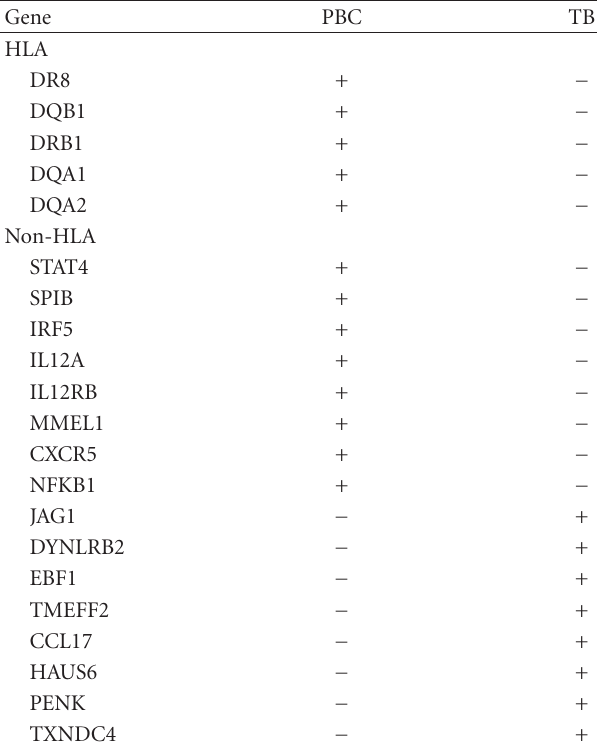
Table 2: Major susceptibility genes associated with tuberculosis [141, 142] and primary biliary cirrhosis [133–140], as reported through genome wide association studies. Note that no positive associations are significantly shared between primary biliary cirrho- sis (PBC) and pulmonary tuberculosis